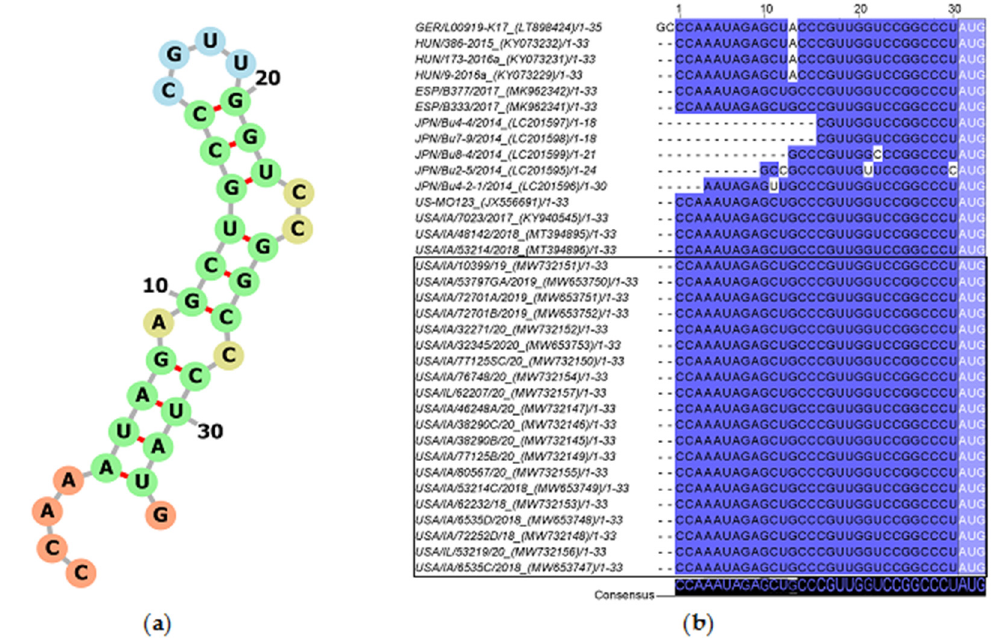
Figure 2. Consensus 5 ′ UTR secondary RNA structure of USA PoAstV3 ( a ). Percent identity of 34 PoAstV3 5 ′ UTR and 5 ′ UTR of strain GER/L00919-K17/2014 ( b ). Darker blue tone indicates homologous bases. Note the inclusion of 5 ′ UTR of strain GER/L00919-K17/2014 with initial 5 ′ GC bases only present in this strain. GenBank accession within parentheses.